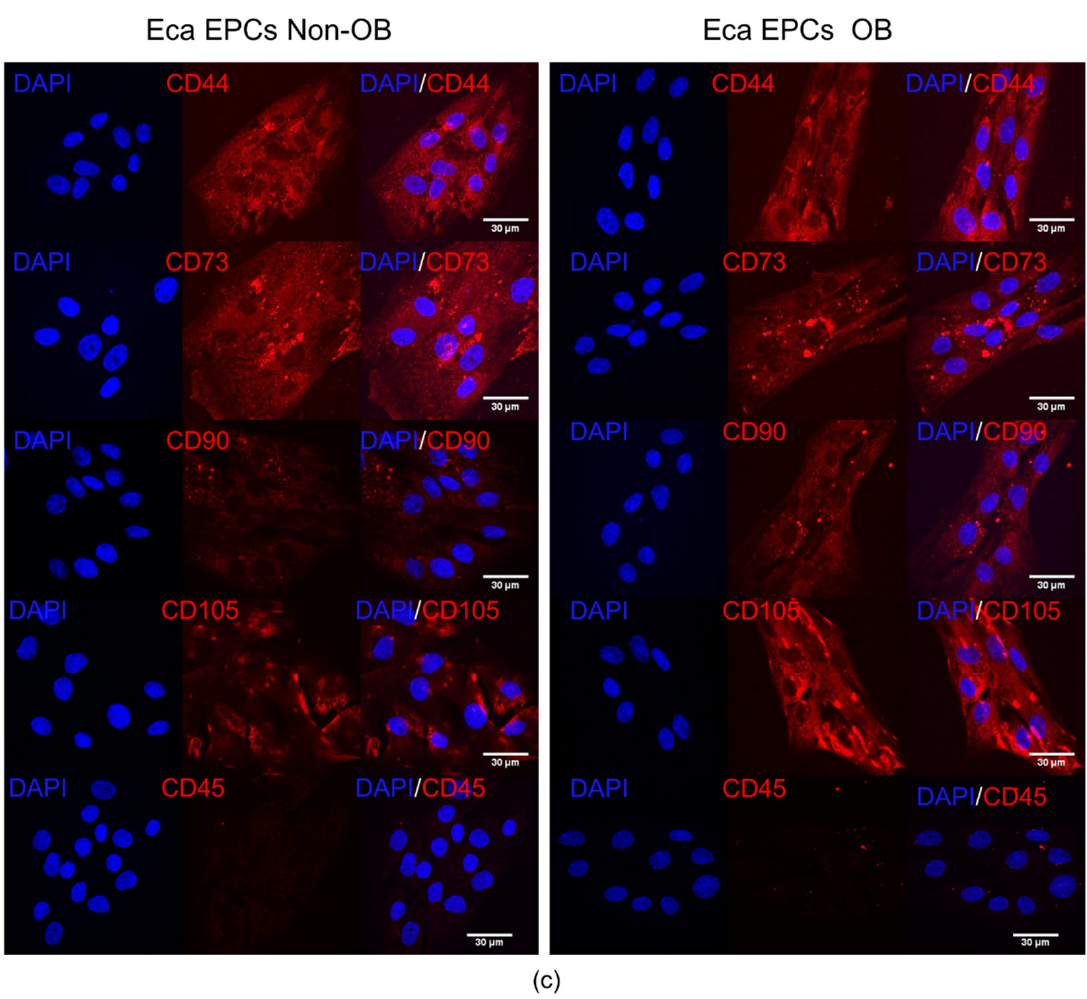
Figure 1. Phenotype of Eca EPCs. The RT-qPCR analysis aimed to determine relative transcript levels of cell surface markers ( a ). The mRNA expression was established for MSCs markers (CD29, CD44, CD90, CD105), perivascular markers (NG2, CD146), epithelial marker (MUC-1) and smooth muscle markers (ACTA2, CNN1, MHY11). The mRNA expression for hematopoietic markers (CD34, CD45) was not included on the graphs due to the lack of a specific signal. The PCR products were analyzed using electrophoresis ( b ). The cellular phenotype was tested using immunocytochemistry. The scale bar indicated on merged figures is equal to 30 μ m ( c ). All results are shown as mean ± SD. Columns with bars represent means ± SD. * p -value < 0.05, **** p -value < 0.0001, while ns symbol refers to non-significant differences.